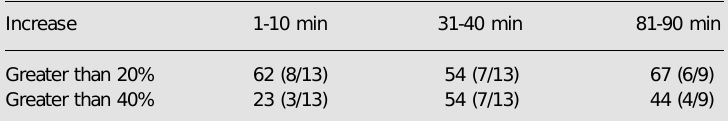
Table 3. Number of animals subjected to acupuncture stimulation (group I) with a greater than 20% increase in myoelectric activity over baseline, as measured by root mean square or a greater than 40% increase in myoelectric activity over baseline during the initial 10 min of recording (1-10) or in the middle portion of the recording session (31-40) or at the end of the recording session (81-90).